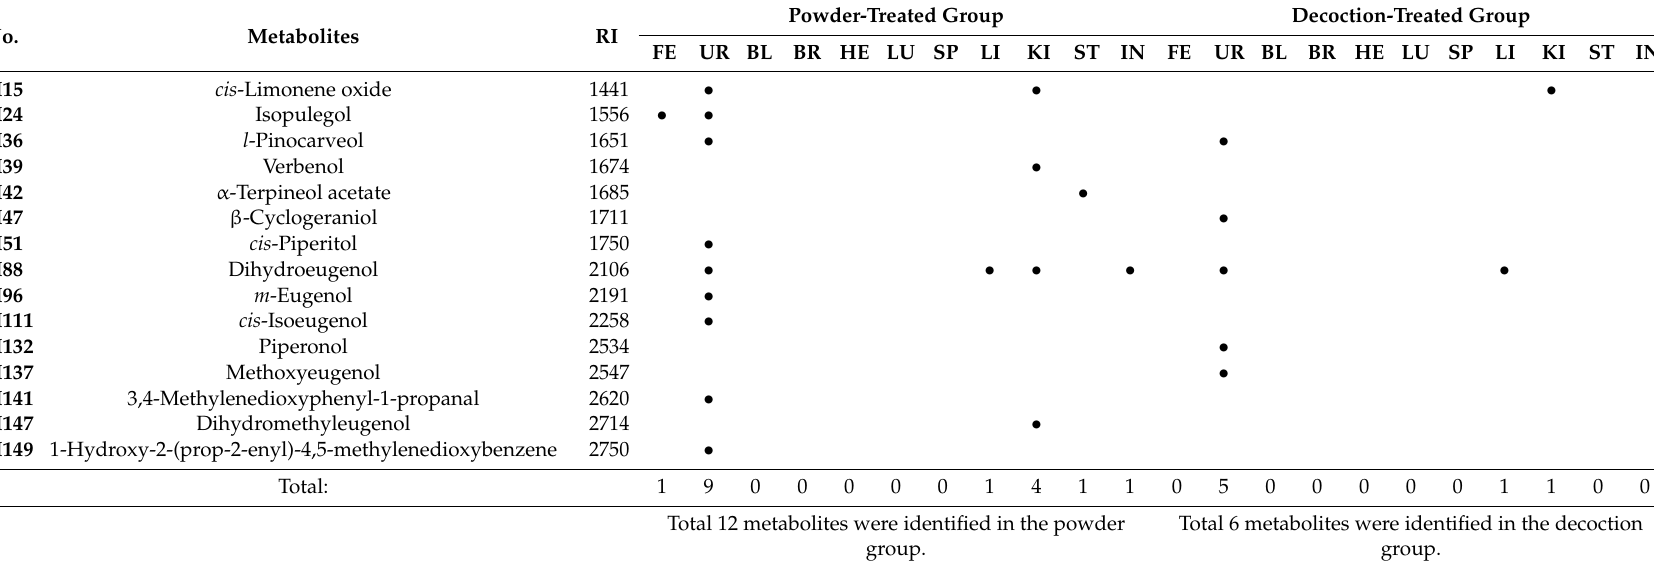
Total 12 metabolites were identified in the powder group.